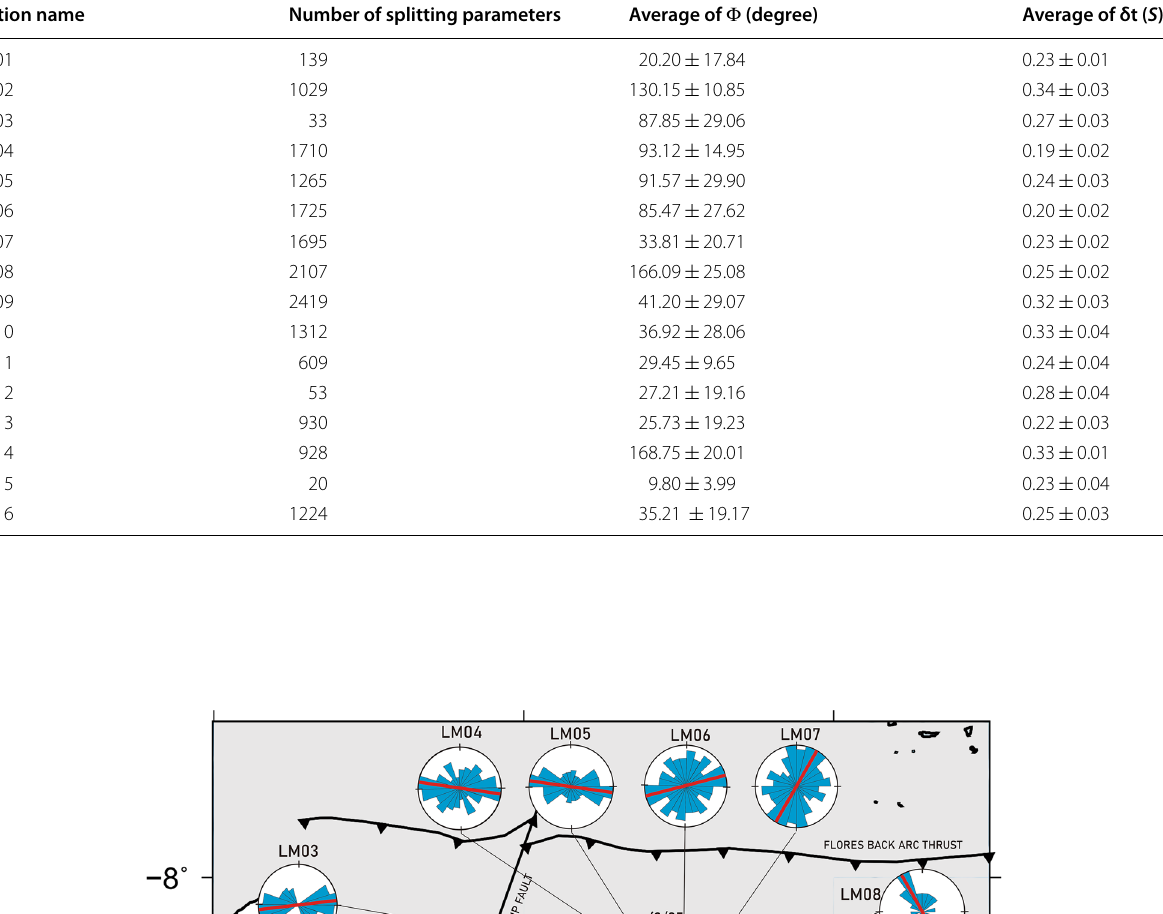
Table 1 Result of SWS parameter measurement